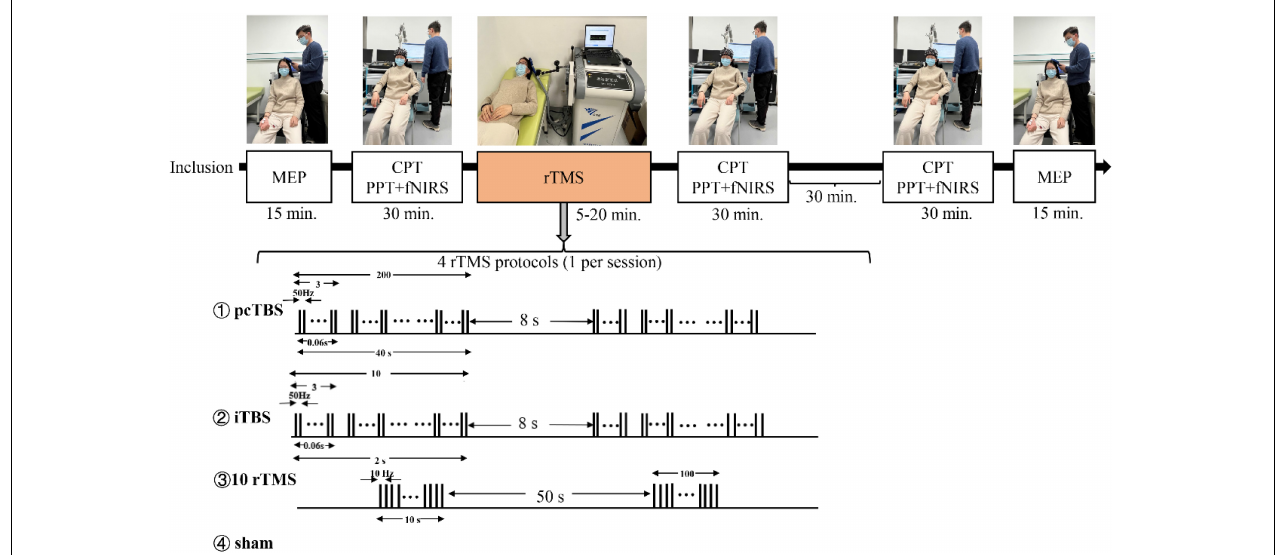
FIGURE 1 | Schematic overview of the whole study. MEP means motor evoked potentials, CPT means current perception thresholds, PTT means pain tolerance threshold, fNIRS means functional near-infrared spectroscopy. Prolonged continuous theta-burst stimulation (pcTBS) consisted of three pulses at 50 Hz repeated 400 times at intervals of 200 ms (1,200 pulses, 1 min and 40 s). Intermittent theta-burst stimulation (iTBS) consisted of three pulses at 50 Hz repeated 10 times at intervals of 200 ms (600 pulses, 3 min and 20 s). 10 Hz rTMS consisted of 15 trains of 10 s with an interval of 50 s (1,500 pulses, 15 min).